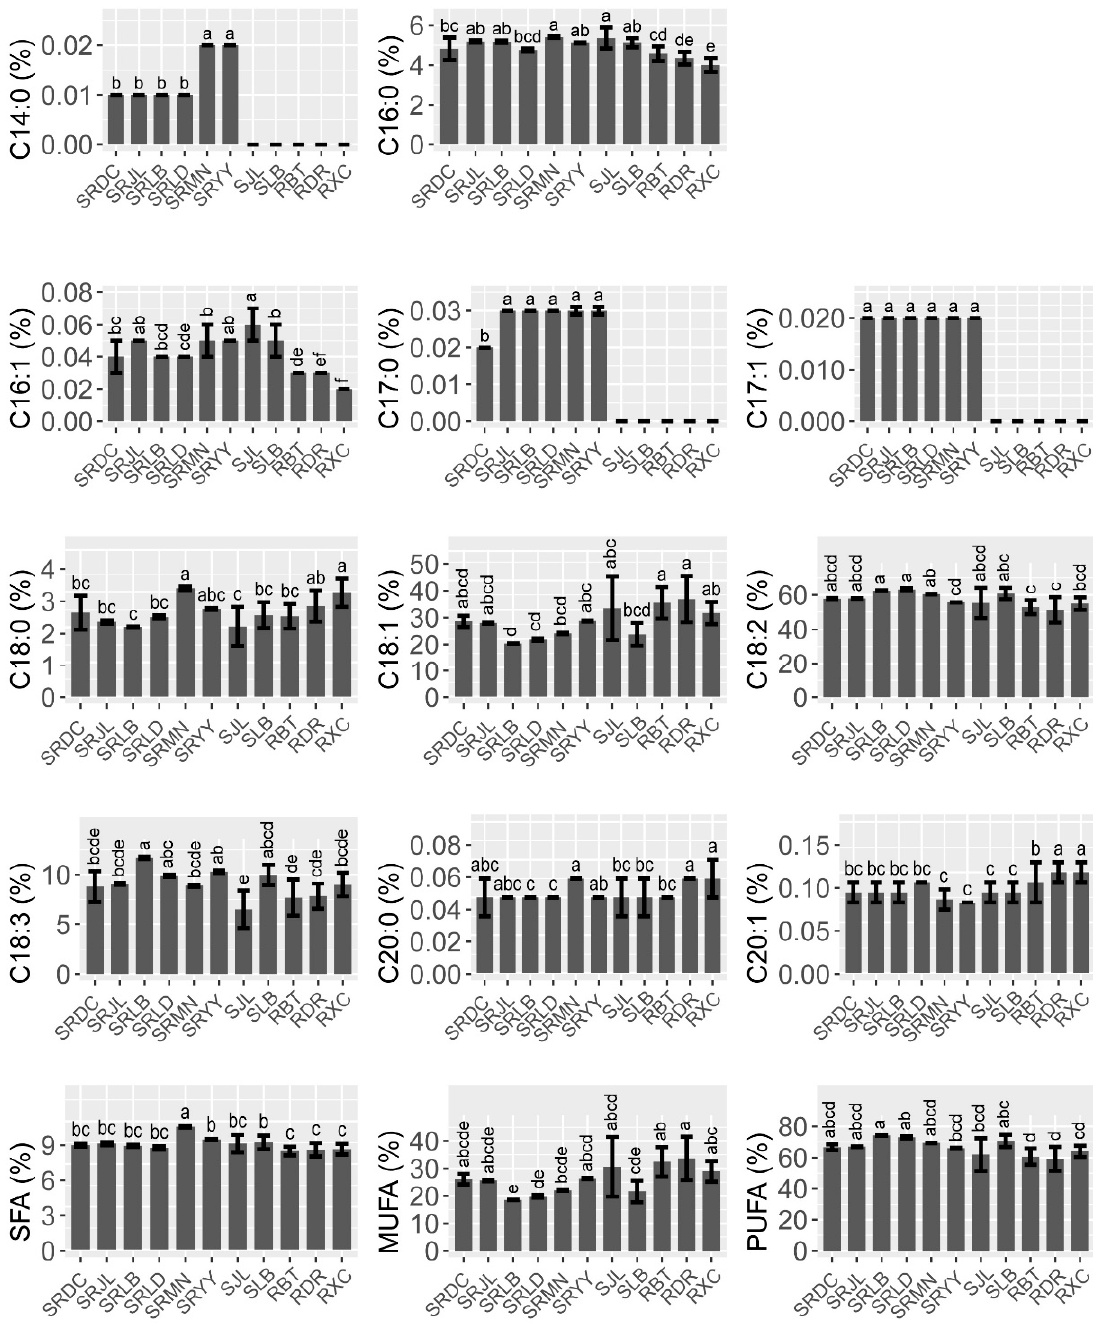
Figure 1. Fatty acid composition and contents of walnut oils. Note: Values are the mean ± standard deviation, and different letters indicate significant differences ( p ˂ 0.05) between different spe- cies/sites. SFAs, saturated fatty acids (C14:0 + C16:0 + C17:0 + C18:0 + C20:0); MUFAs, monounsatu- rated fatty acids (C:16:1 + C17:1 + C18:1 + C20:1); PUFAs, polyunsaturated fatty acid (C18:2 + C18:3), the same as below.